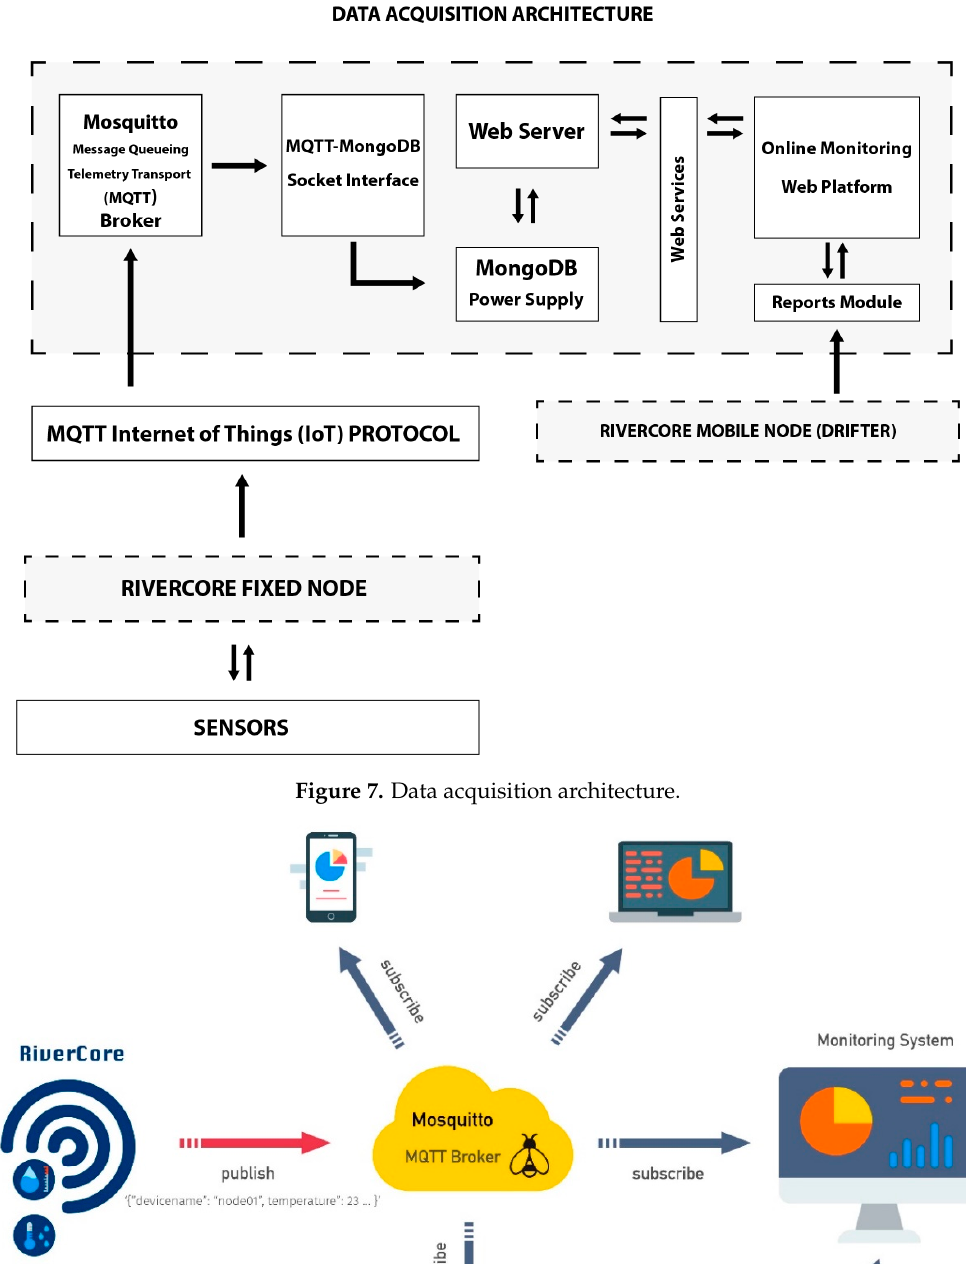
Figure 8. Web platform scheme.